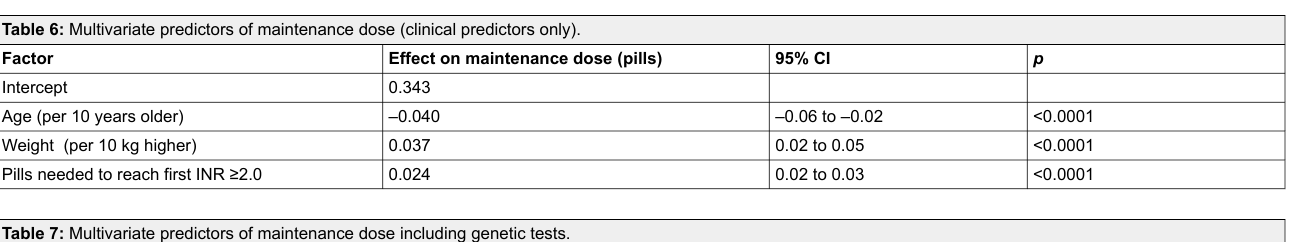
Table 7: Multivariate predictors of maintenance dose including genetic tests. Factor Effect on maintenance dose